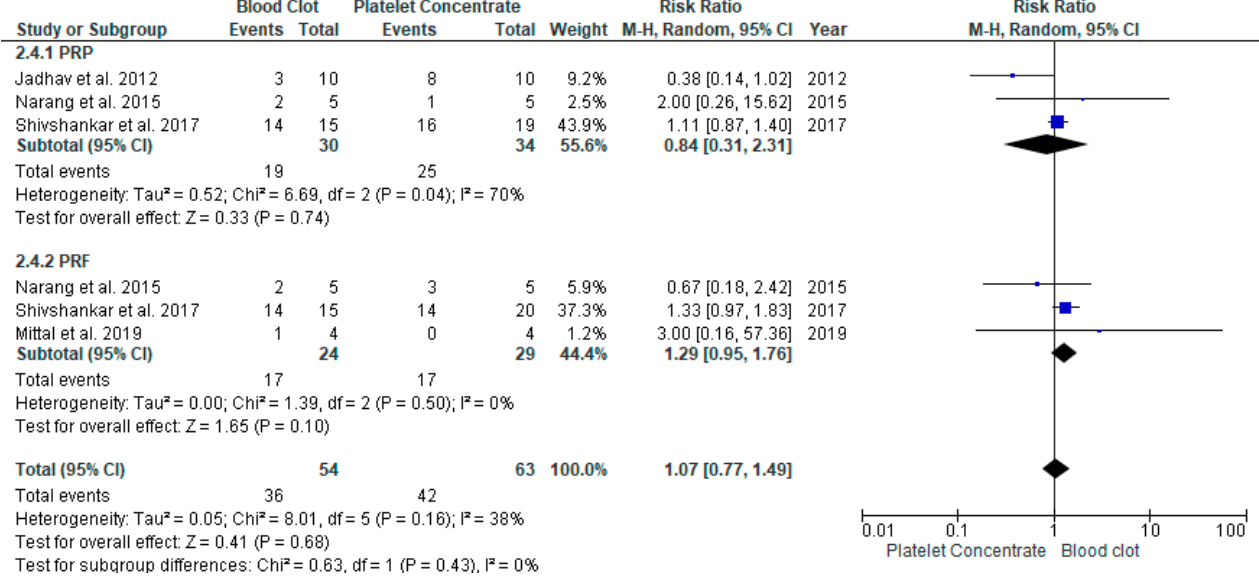
Figure 4. Meta-analysis of dentin wall thickness (DWT) in regenerative endodontic procedure (REP) using APC or BC.